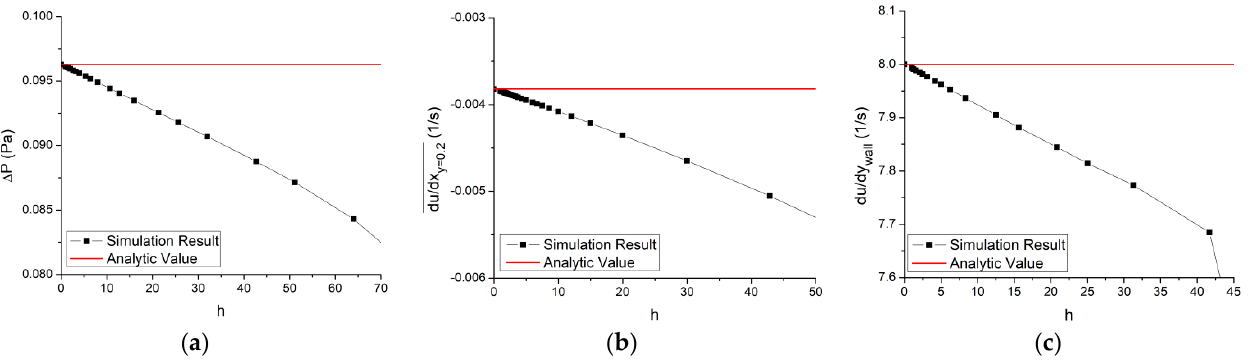
Figure 4. The MMS simulation result that fits condition B: ( a ) Case 12; ( b ) Case 24; ( c ) Case 30.